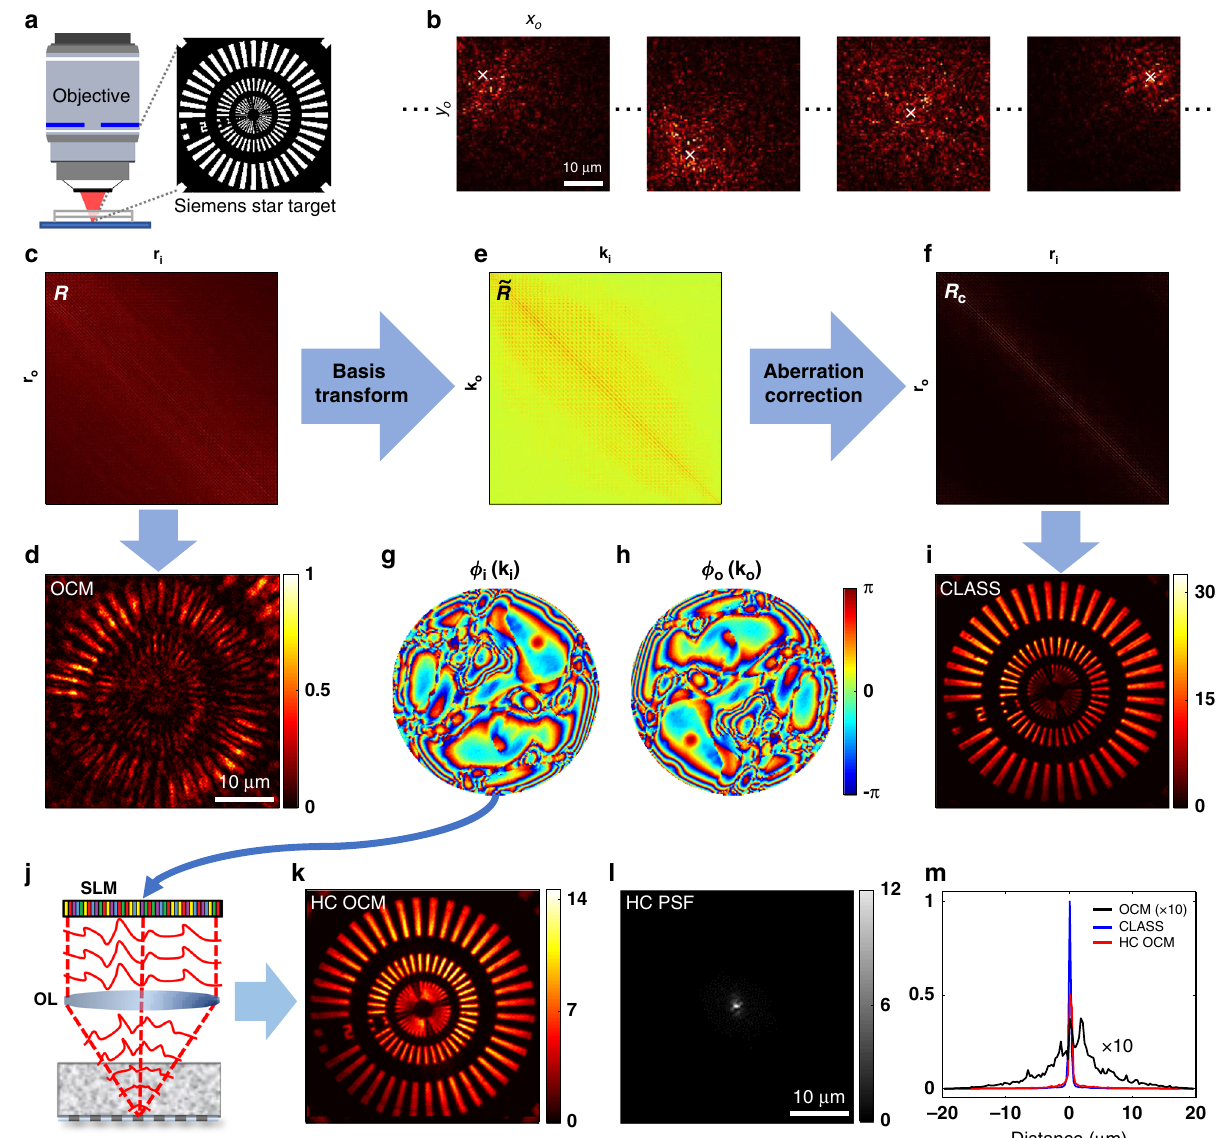
Fig. 2 Aberration correction by the time-resolved re fl ection matrix. a Sample geometry; a custom-made Siemens star target was placed under a 600- µ m- thick, rough-surfaced plastic layer exhibiting strong aberrations. b Set of E- fi eld images of re fl ected waves E lab ( r o ; r i ) in the laboratory coordinates r o = ( x o , y “ × ” marks indicate illumination points r fi ned by the image size was set to o ). Four representative amplitude images are shown. The white i . The FOD de 40 × 40 µ m 2 . Scale bar, 10 µ m. c Time-resolved re fl ection matrix R ( r o ; r i ) in the position space constructed from the set of E- fi eld images in b . Each image was converted to a column vector and assigned to its corresponding column in R . d OCM intensity image constructed from the main diagonal of R in c before aberration correction. Scale bar, 10 µ m. e Re fl ection matrix ~ R in spatial frequency space. f Aberration-corrected re fl ection matrix R c converted from ~ R after application of CLASS algorithm. g , h Phase maps ϕ ϕ i ( k i ) and o ( k o ) for aberrations in illumination and detection pupils retrieved by the CLASS algorithm, respectively. The radii of the maps correspond to a numerical aperture of 1.0. The number of modes N c used for aberration correction in the pupil was about 6200. i Aberration-corrected CLASS intensity image obtained from the main diagonal of R c in f . j Schematic of hardware wavefront correction. Conjugate of the illumination pupil phase map in g displayed on the SLM in Fig. 1a to physically compensate for the aberrations. k OCM intensity image after hardware correction (HC) of aberrations. l Intensity image of re fl ected PSF measured at the camera after physical aberration correction by SLM (HC PSF). Scale bar, 10 µ m. m Line pro fi les of the PSFs obtained without wavefront correction (black), after computational wavefront correction by the CLASS algorithm (blue), and after hardware wavefront correction by SLM individual isoplanatic patches. The algorithm is special in that the number of correction modes is maintained at the number of angular modes in full FOD (~10,000) even when the image analysis area is reduced to the isoplanatic patch size of 10 × 10 µm 2 . This is contrary to conventional computational AO, where the number of correction modes is reduced in proportion to the image analysis area.